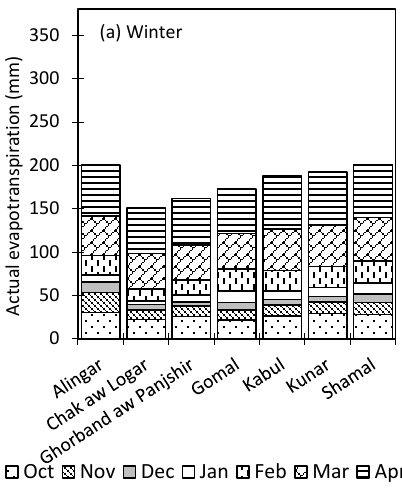
12 of 22 Figure 5. ( a ) Box and whiskers plot of annual evapotranspiration (ET a ), showing the temporal (2003– 2013) and spatial variation of the ET a . The horizontal line inside each box represents the median, the lower and upper whiskers show the ET a range during the study period. The outliers are encircled with a dotted line. ( b ) Temporal variation (2003–2013) of actual evapotranspiration of main land covers across the Kabul River Basin. 3.3. Monthly Distribution of Actual Evapotranspiration Across the KRB, Constituent Sub-Basins and Provinces The mean annual ET a shows that the usual highest values of ET a across the KRB are in the months of May–July, which are around 70 ± 1.6 mm. The seasonal variability in the ET a in the summer season (May–September) across the KRB stays almost consistent with a seasonal mean ET a of 333 ± 19 mm. Overall, the least monthly mean ET a for the month of January and December across all the sub-basins was 9 ± 3 mm) and (7 ± 1 mm), respectively (Figure 6a,b). The Panjshir province experienced the lowest mean ET a in the winter season during the study period (Figure 6c). Similarly the highest ET a in summer season among provinces was observed by Kunar and Nangarhar provinces due to their relatively easier access to river and canal water supplies